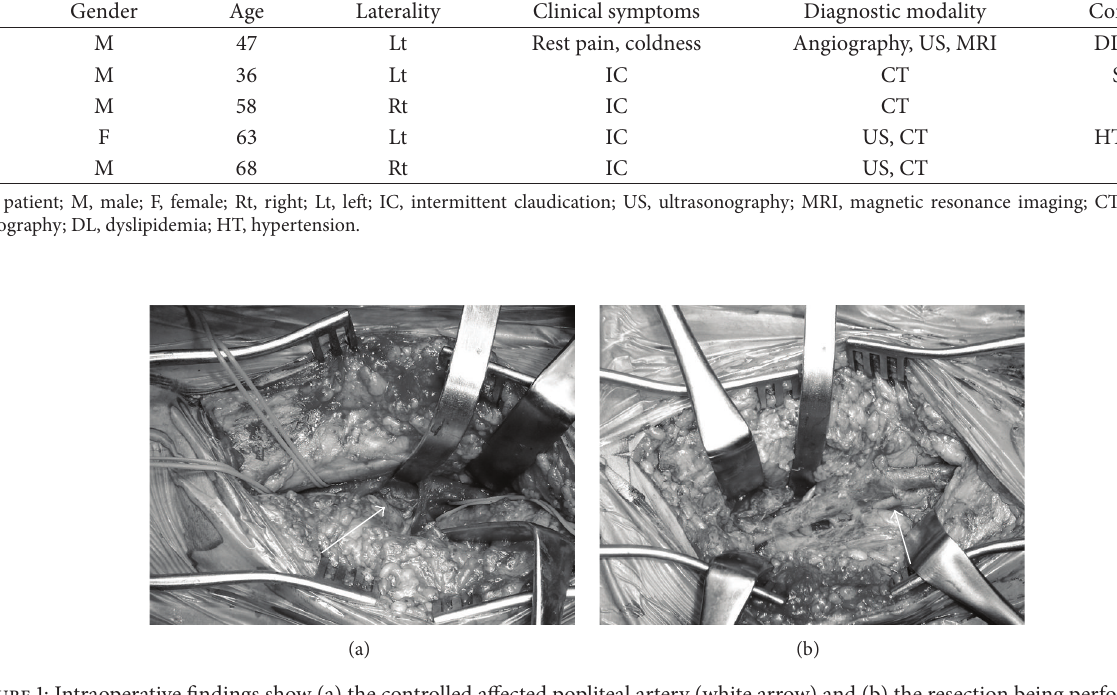
Figure 1: Intraoperative findings show (a) the controlled affected popliteal artery (white arrow) and (b) the resection being performed with an interposition graft (white arrow). The patient’s head was to the